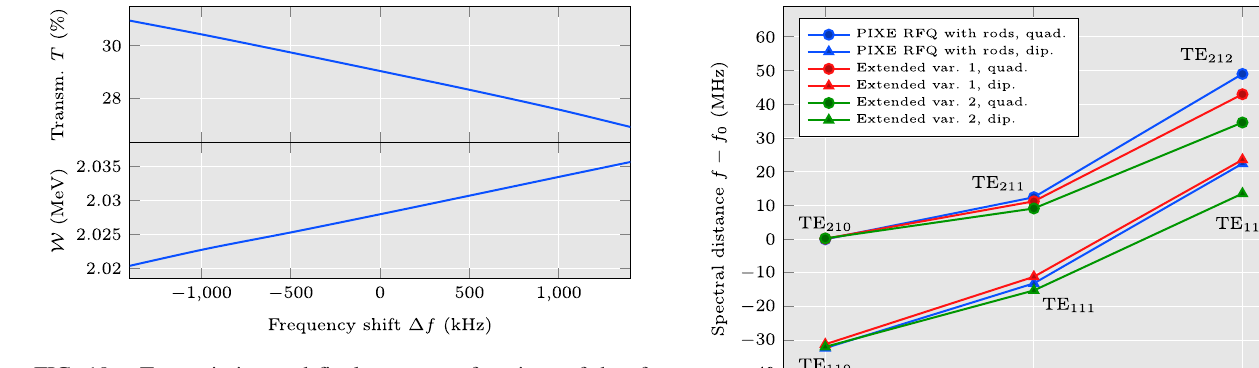
FIG. 19. Transmission and final energy as functions of the rf frequency. The magnitude of the frequency shift caused by the heat-induced deformation of the cavity is expected to be less than 200 kHz.